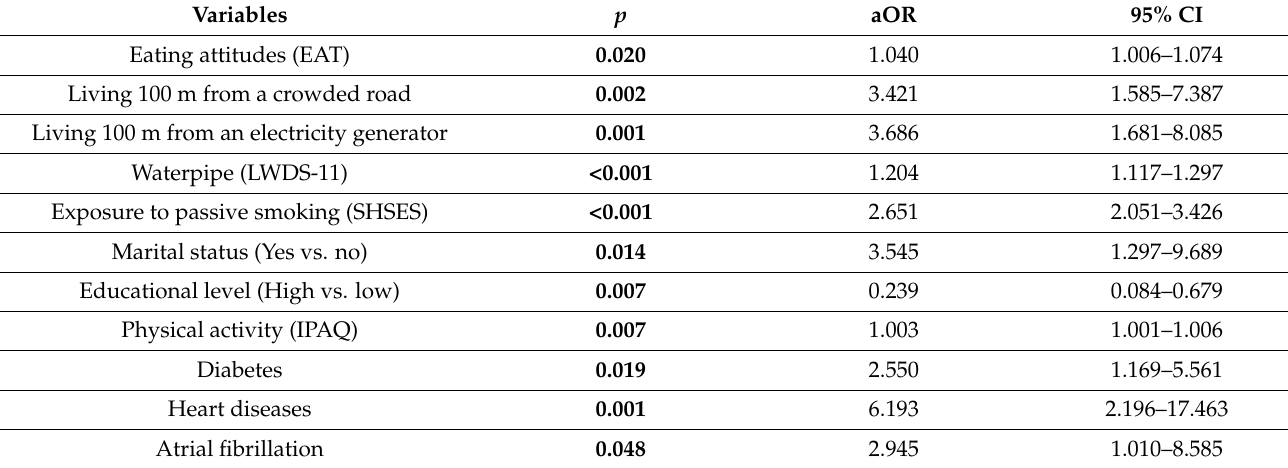
Table 3. Adjusted odds ratios with their 95% confidence intervals from the logistic regression of ischemic stroke among cases and